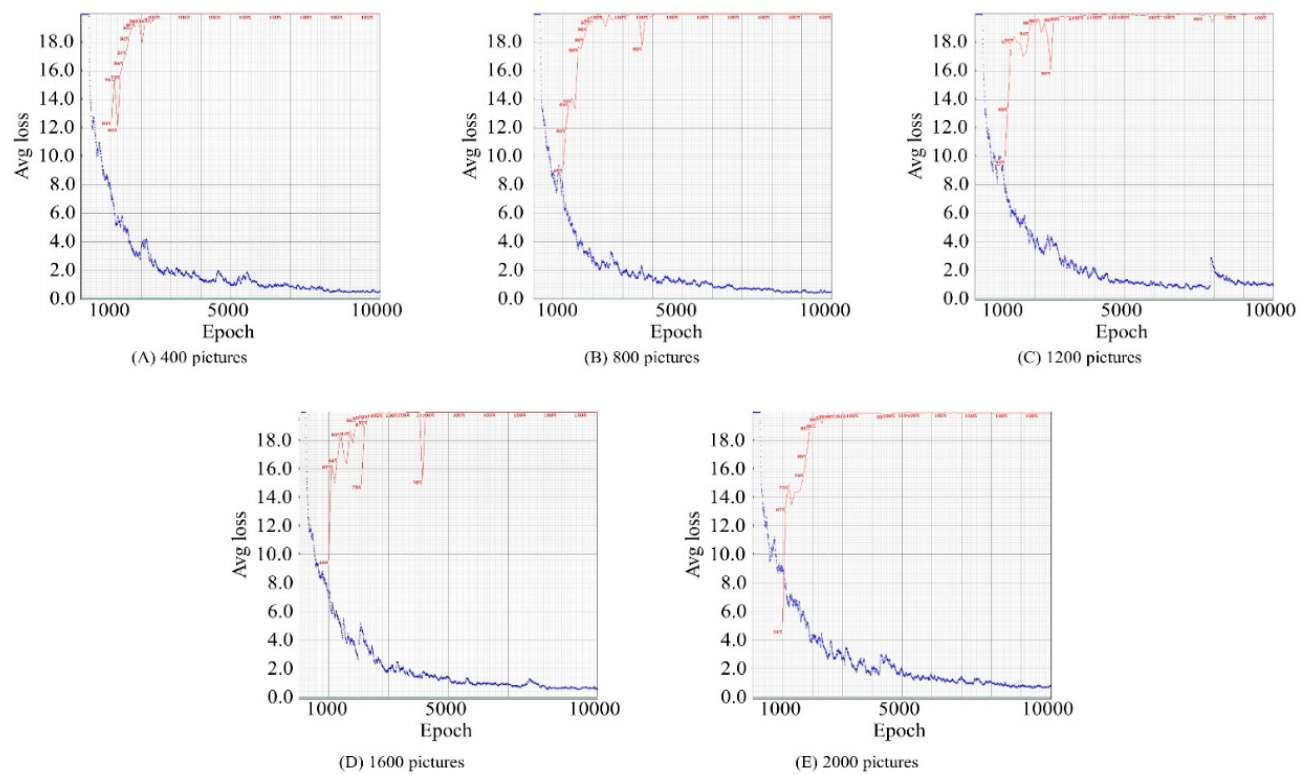
Figure 5. Training results. The blue line is the AVG loss and red line is the mAP.